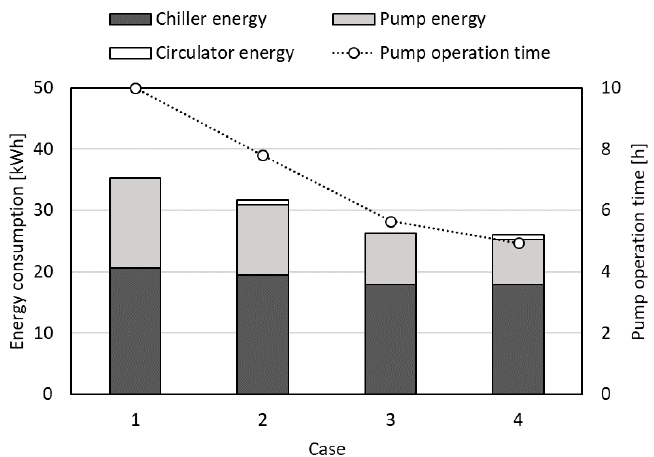
Figure 9. Comparison of energy consumption in each case. Table 5. System operation time and electricity consumption.